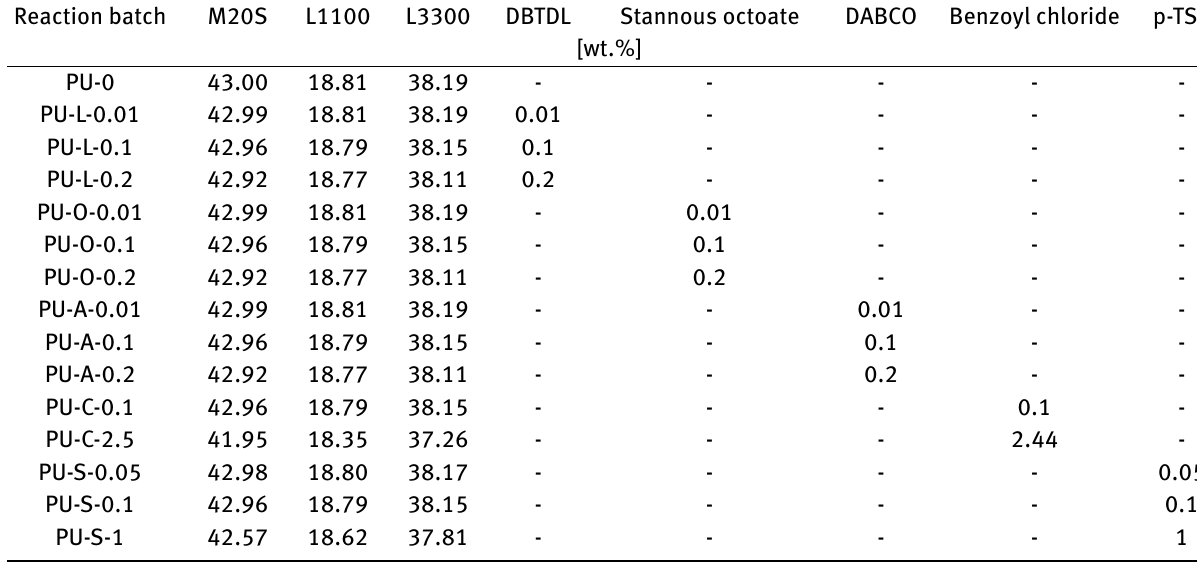
Table 2: Weight fraction of basic reactants with different catalysts and inhibitors Reaction